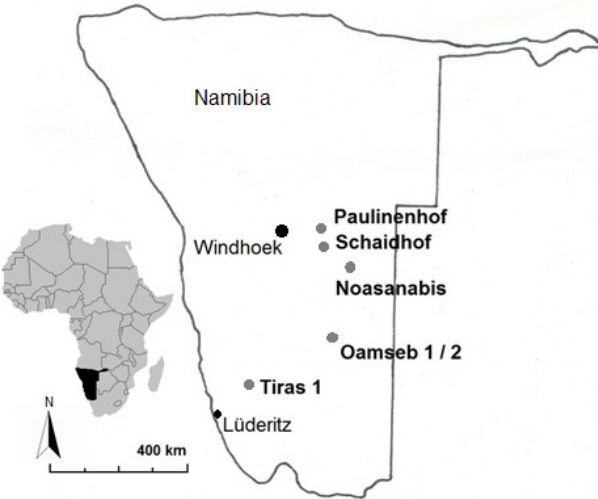
Fig 1. Map of the six sampling sites in Namibia. One sampling site (plot) represents one community with one ha in